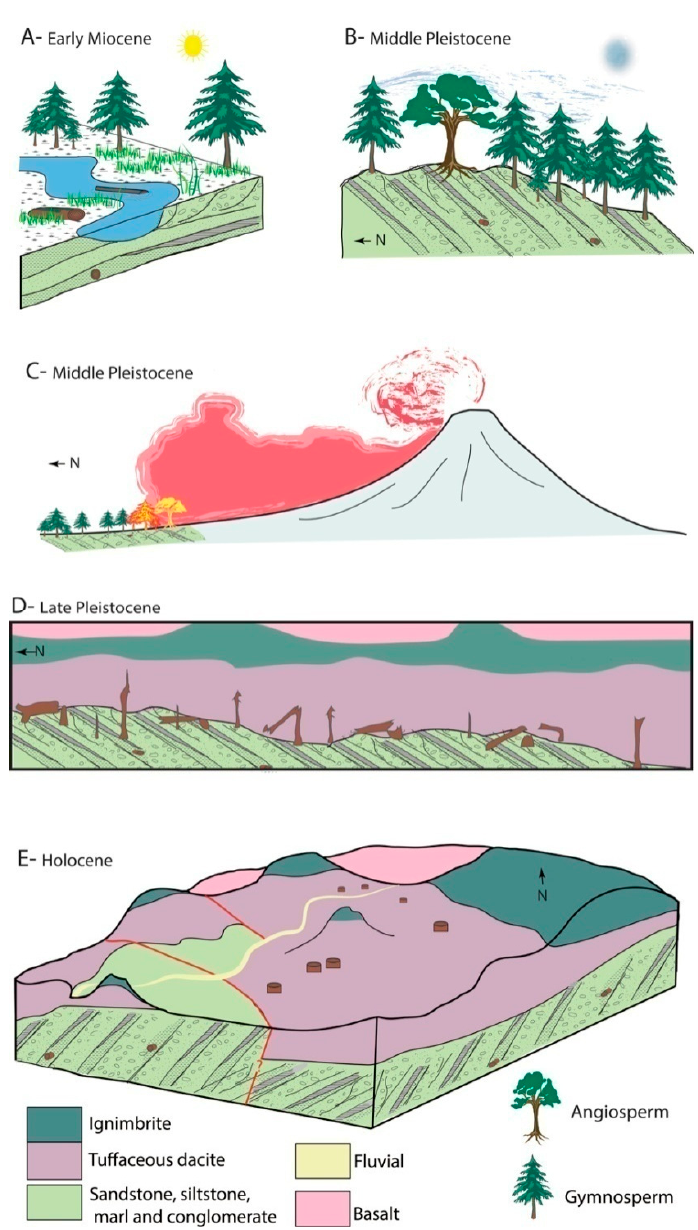
Figure 23. ( A ) Miocene floodplain forest. ( B ) By the middle Pleistocene, tilted sediments were eroded to produce a new land surface where forests flourished. ( C ) Episodic eruptions of Mt. Sabalam produced pyroclastic flows that buried local forests. ( D ) Later, deposition of basalt and ignimbrite provided a capping layer. ( E ) Uplift and erosion combined to expose the Meshgin Shahr Fossil Forest.